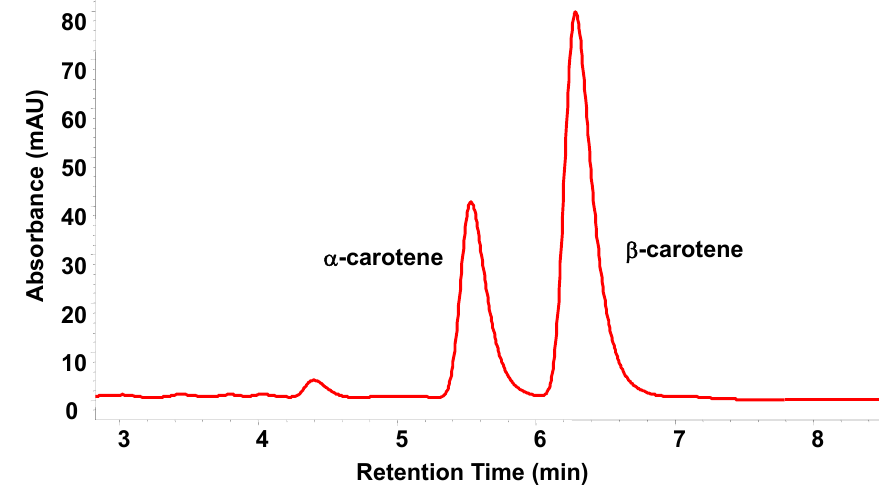
Figure 4. HPLC-UV chromatogram of carrot extract using PFE, λ =